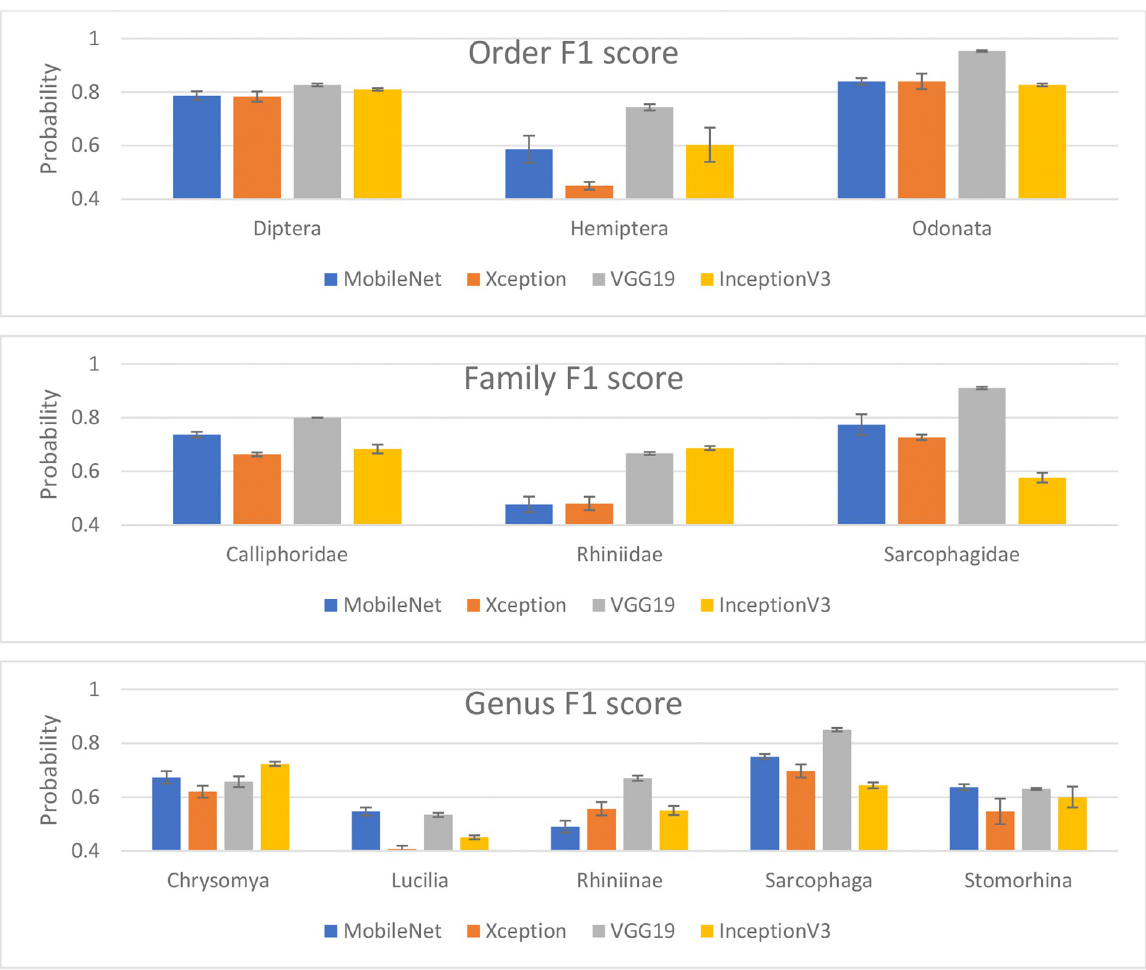
Fig 4. Model classification based on the individual group within the